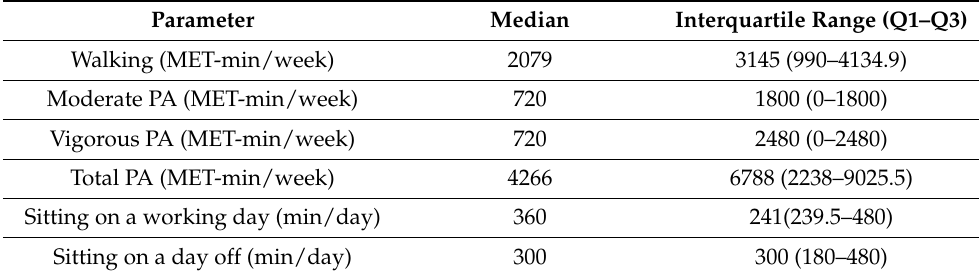
Table 2. Characteristics of PA assessed by